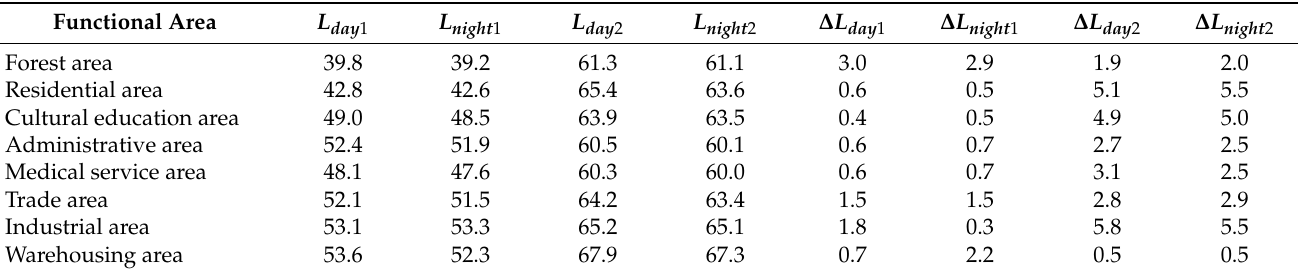
Table 5. Minimum and maximum noise levels of different functional areas in Panyu District of Guangzhou City with the existence of noise barriers. The numbers 1 and 2 stand for minimum and maximum, respectively. All units are in